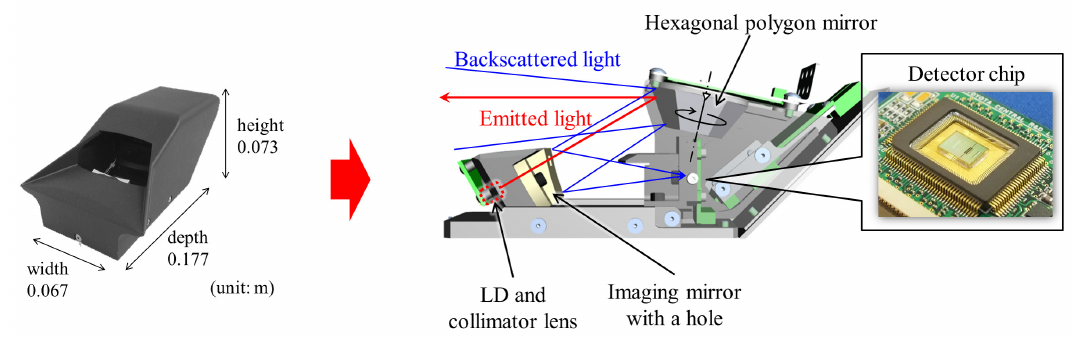
Figure 3. Single-photon avalanche diode (SPAD) light detection and ranging (LiDAR). Table 1. Main specifications of the single-photon avalanche diode (SPAD) light detection and ranging (LiDAR).